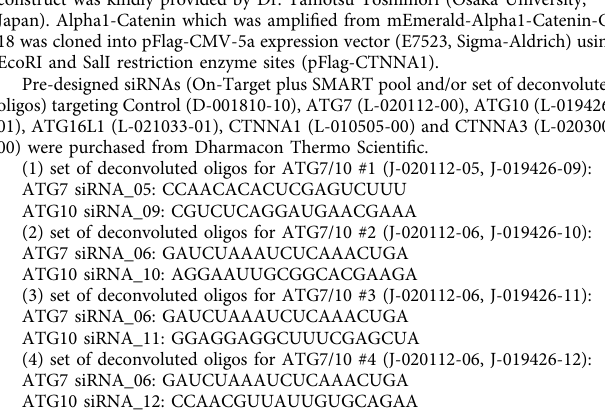
Table 1. PCR products were incubated with Dpn1 restriction enzyme for 1h and then mixed with XL-10 Gold-competent cells. After transformation, DNA